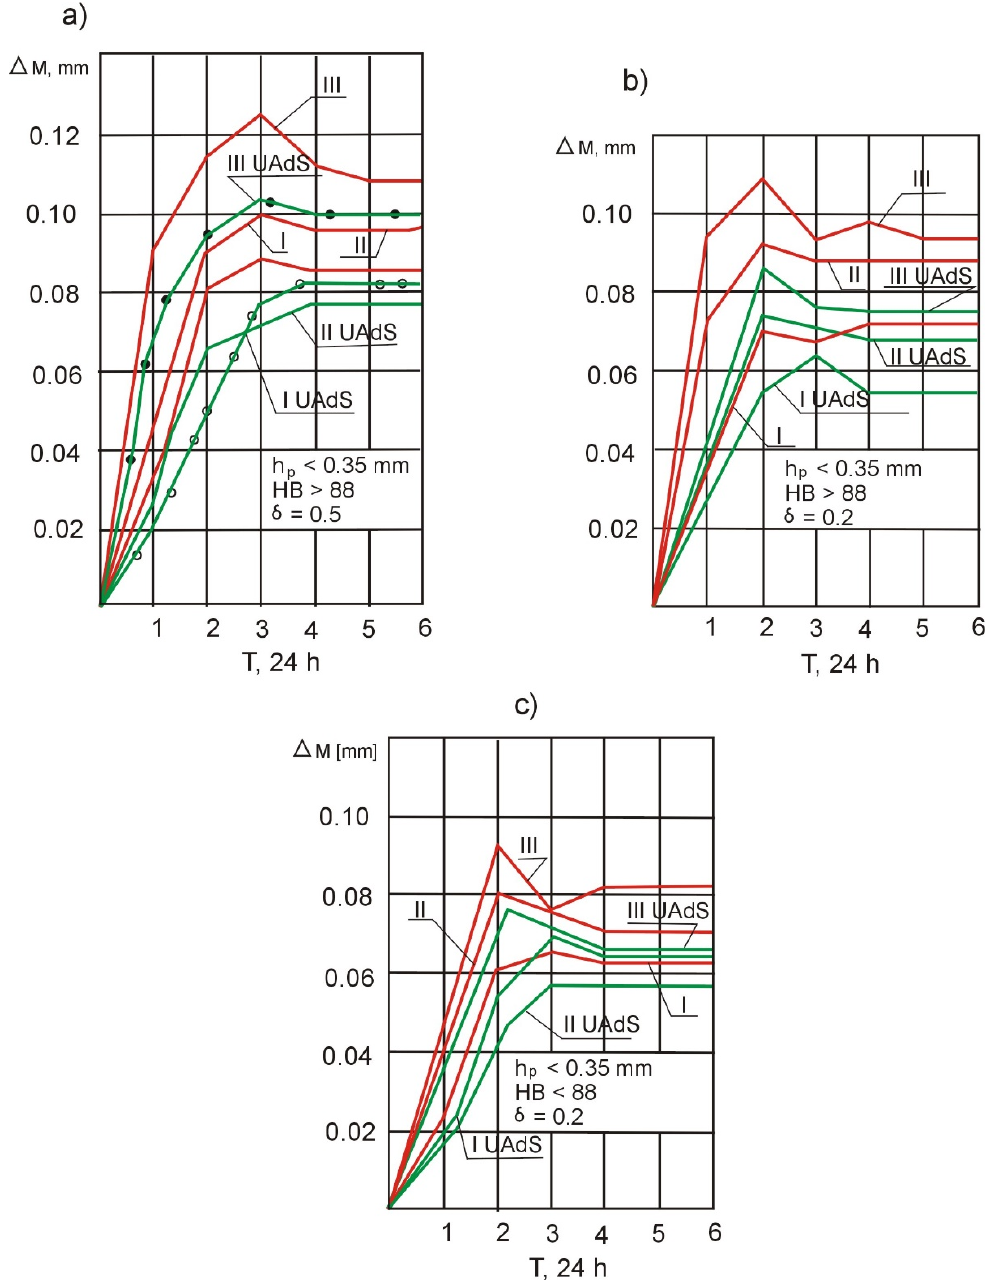
Figure 9. Changes in long-term dimensional stability of parts depending on the processing method used (with electro-contact heating control system – I and without the electro-contact heating control system - II) and the density of workpiece structure - III: ( a ) at maximum runout δ = 0.5 · 10 − 3 m; ( b ) at minimum runout δ = 0.2 · 10 − 3 m; and ( c ) at a minimum density of the Ti-64 workpiece HB < 88.